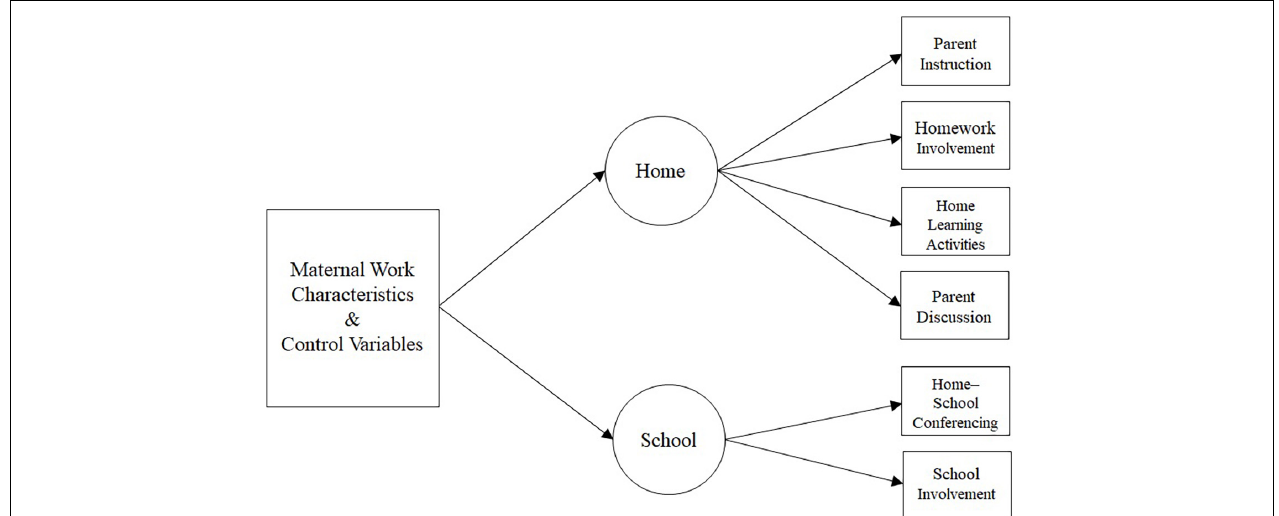
FIGURE 2 | Structural